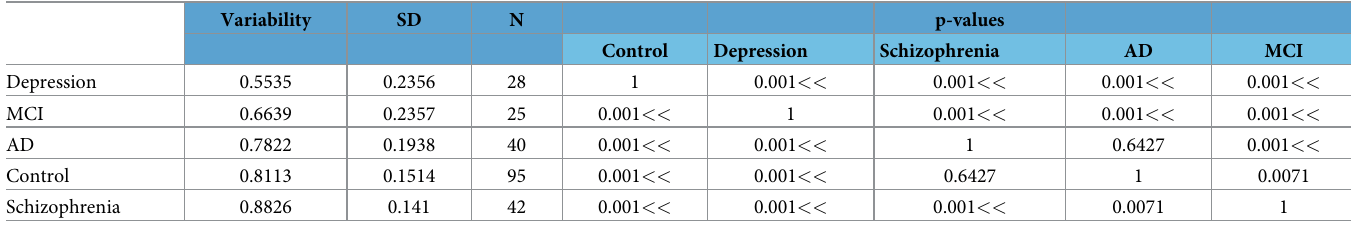
Table 6. Cross correlation analysis between participant’s electrodes–non-local.